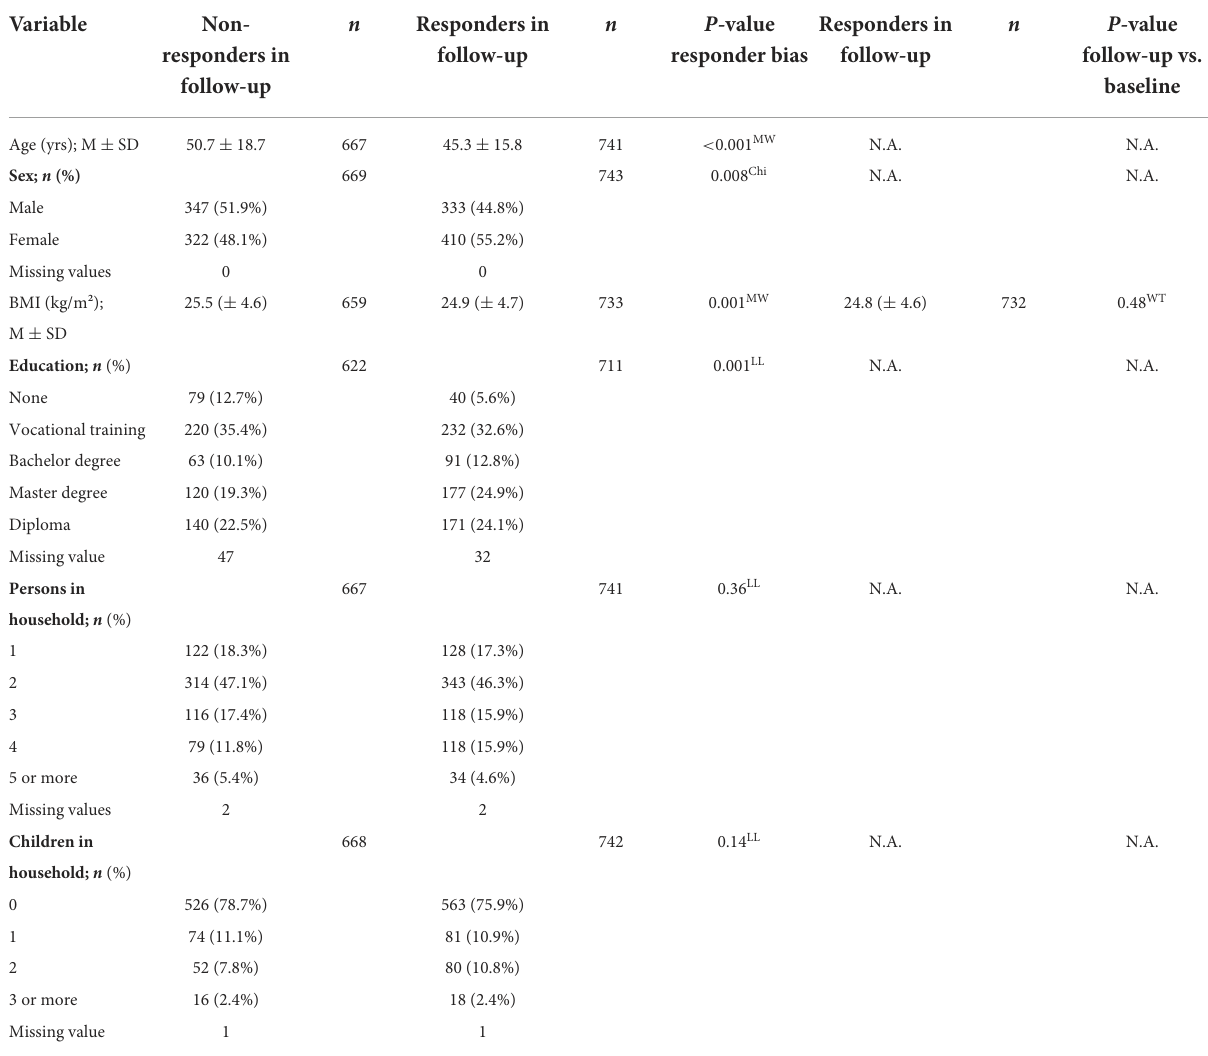
P -value follow-up